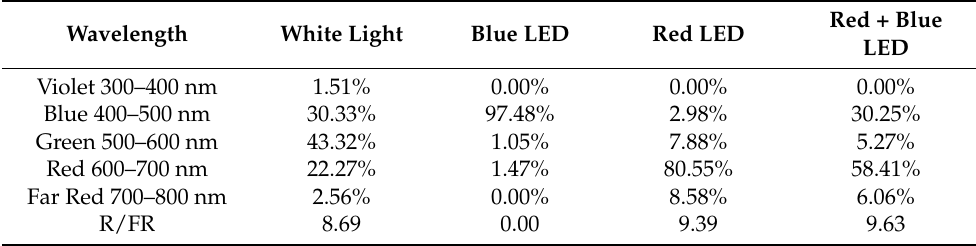
Table 1. Relative percentage distribution of the different wavelengths for white light (cold white fluorescent lamp) and blue, red, and red + blue LED